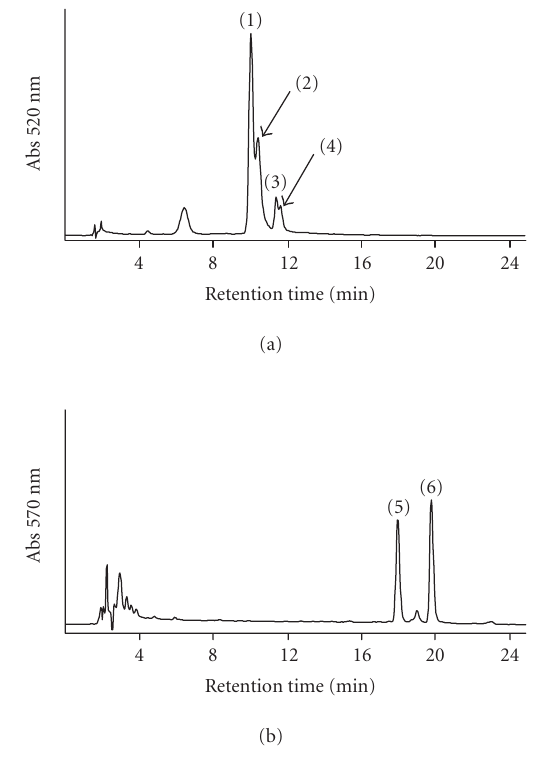
Figure 6. HPLC chromatograms of an elderberry extract. (a) anthocyanins after 2days of reaction with pyruvic acid: Cy-3- (samb)-5-gluc (1), Cy-3-samb + Cy-3-gluc (2), Cy-3-samb-py (3), Cy-3-gluc-py (4); (b) portisins: vinylpyranoCy-3-samb (5), vinylpyranoCy-3-gluc